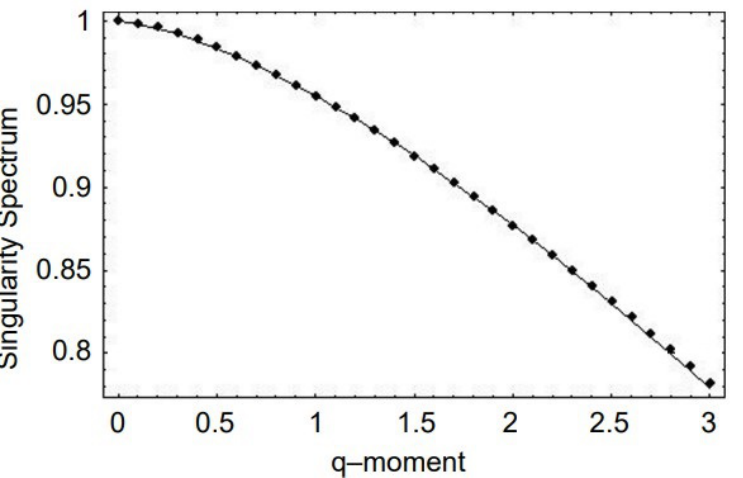
Figure 8. The singularity spectrum for q > 0 obtained through the numerical fit to the human gait data. The curve is the best mean square fit of Equation (26) to the average over the ten data sets [10] and which determine the two parameters b = 0.1 and β = 1.45. From [78] with